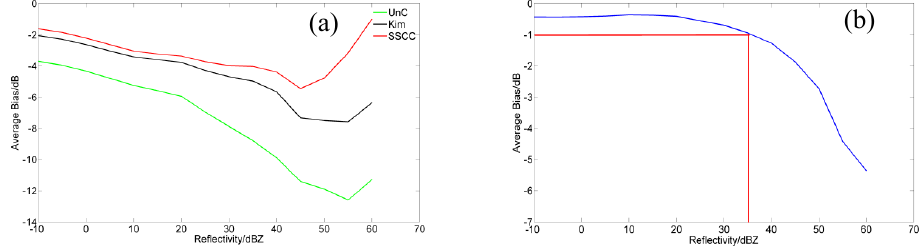
Figure 10. Average biases of the reflectivity for the convective cloud. ( a ) The AB of the uncorrected reflectivity, the reflectivity corrected by Kim et al.’s method and the reflectivity corrected by the SSCC; ( b ) the AB of the difference between the Kim and the SSCC.